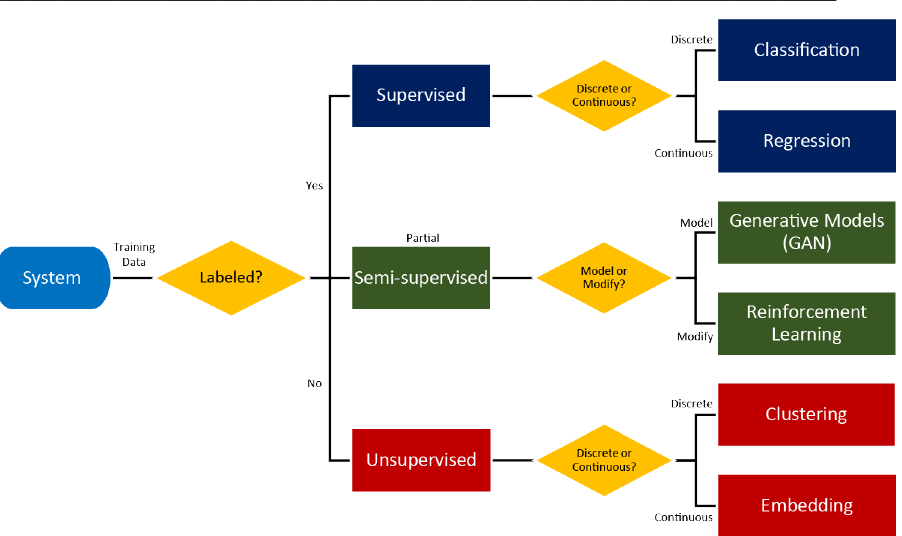
Fig. 3. Types of the Machine Learning based on the input data